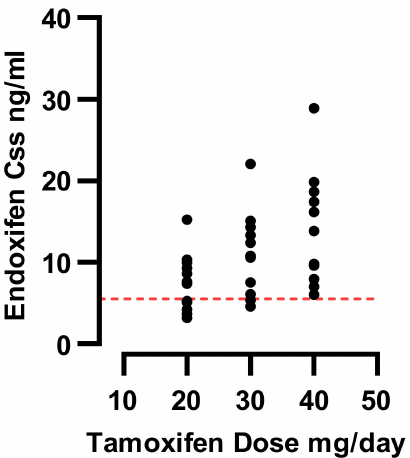
Figure 5. Dose escalation simulation plot of TAM from 20 to 40 mg/day with predicted change of mean steady state ENDO concentration in the CYP2D6*17/*17 arm. The dotted red line shows putative reported ENDO therapeutic threshold at 5.97